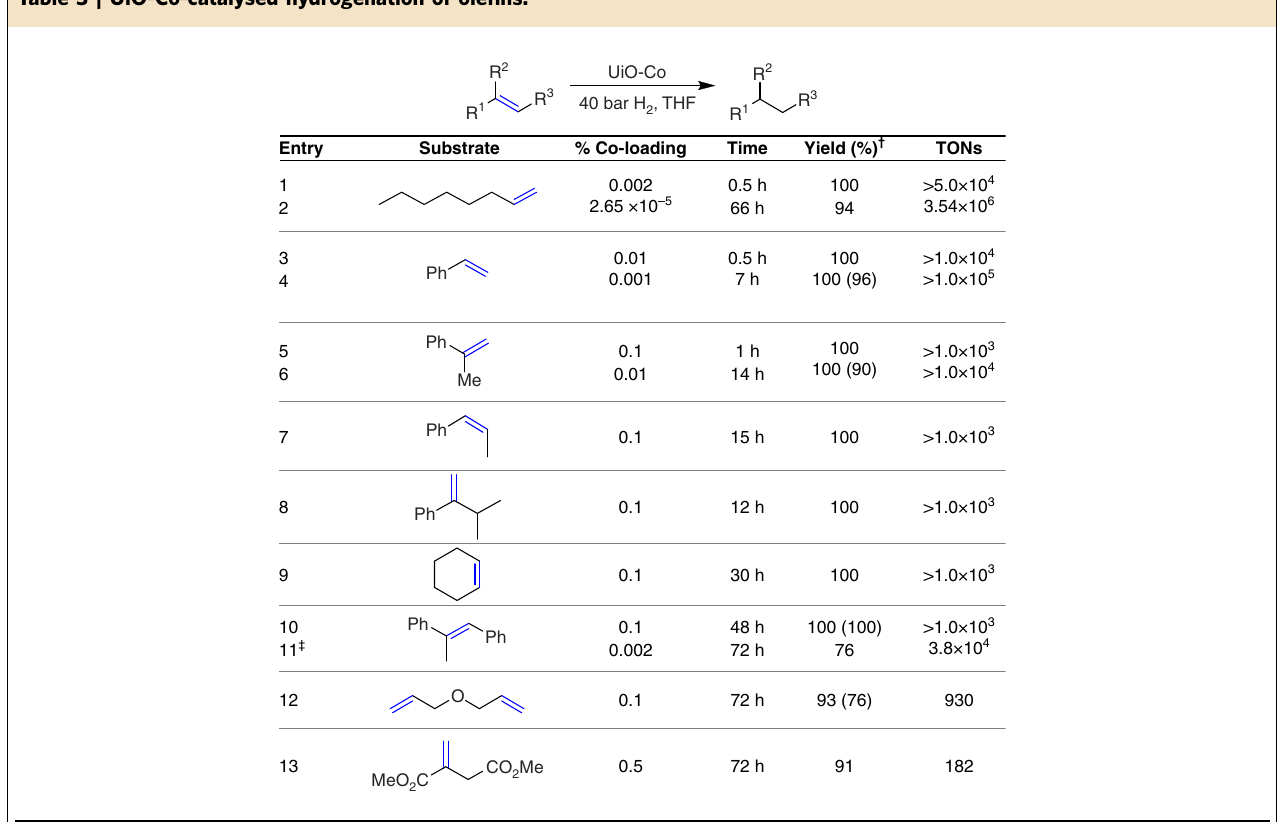
Table 3 | UiO-Co-catalysed hydrogenation of